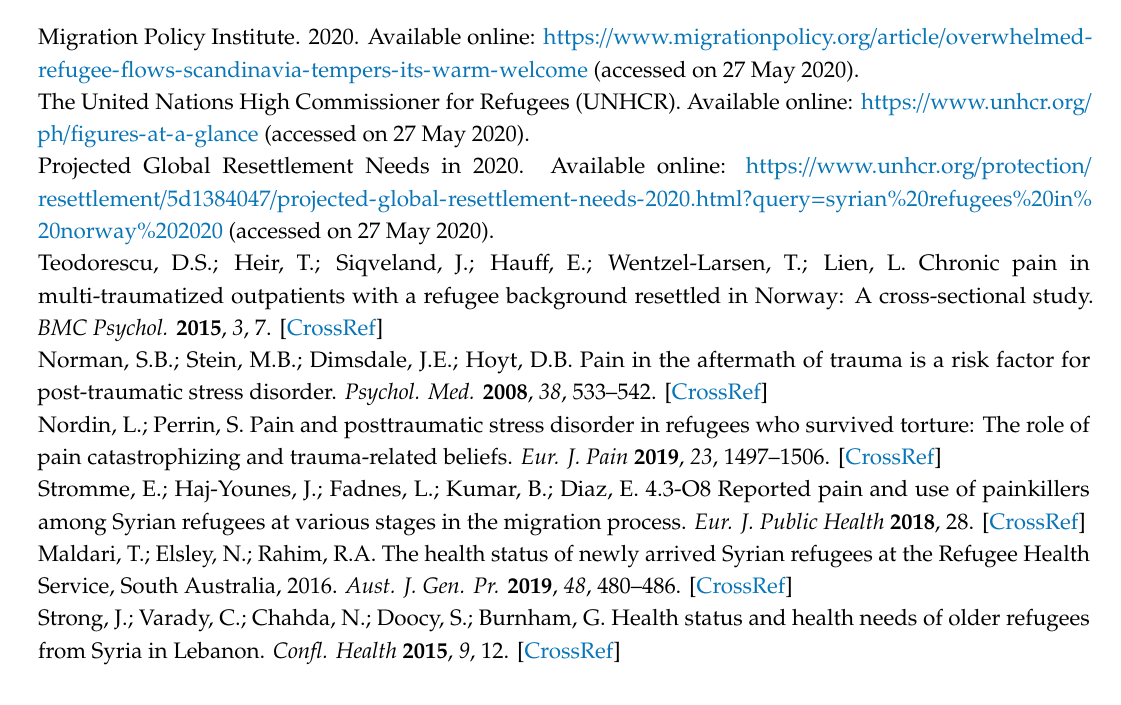
Figure A2. Questions That Will Be Used for Evaluation of PAAI Group Interventions (Sarkadi et al.